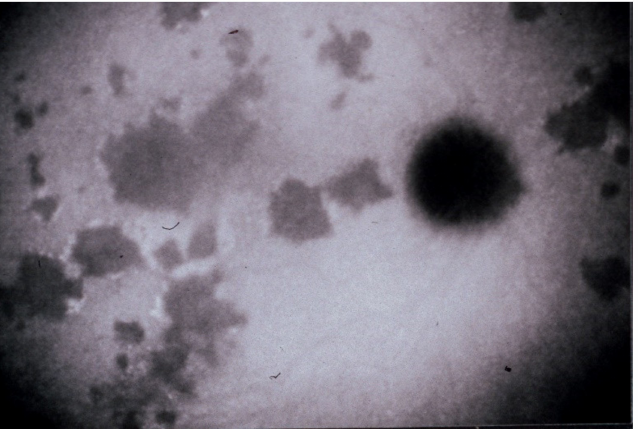
Figure 4. Indocyanine green angiography (ICGA), type 1 pattern: choriocapillaris non-perfusion. Typical geographic areas of dark non-fluorescence in case of acute posterior multifocal placoid pigment epitheliopathy or acute multifocal ischaemic choriocapillaritis